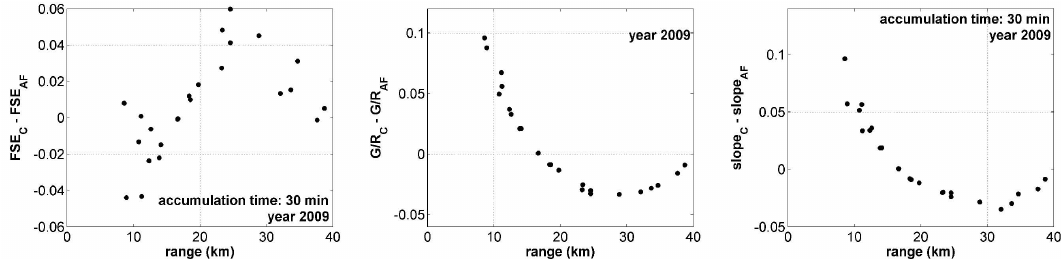
Fig. 19. Differences between FSE, G/R , and slope values before and after the AF correction, within the range of distances 0–40km. Figure refers to the year 2009. Subscripts C and AF refer to two different processing levels, namely after calibration and at the end of the adjustment